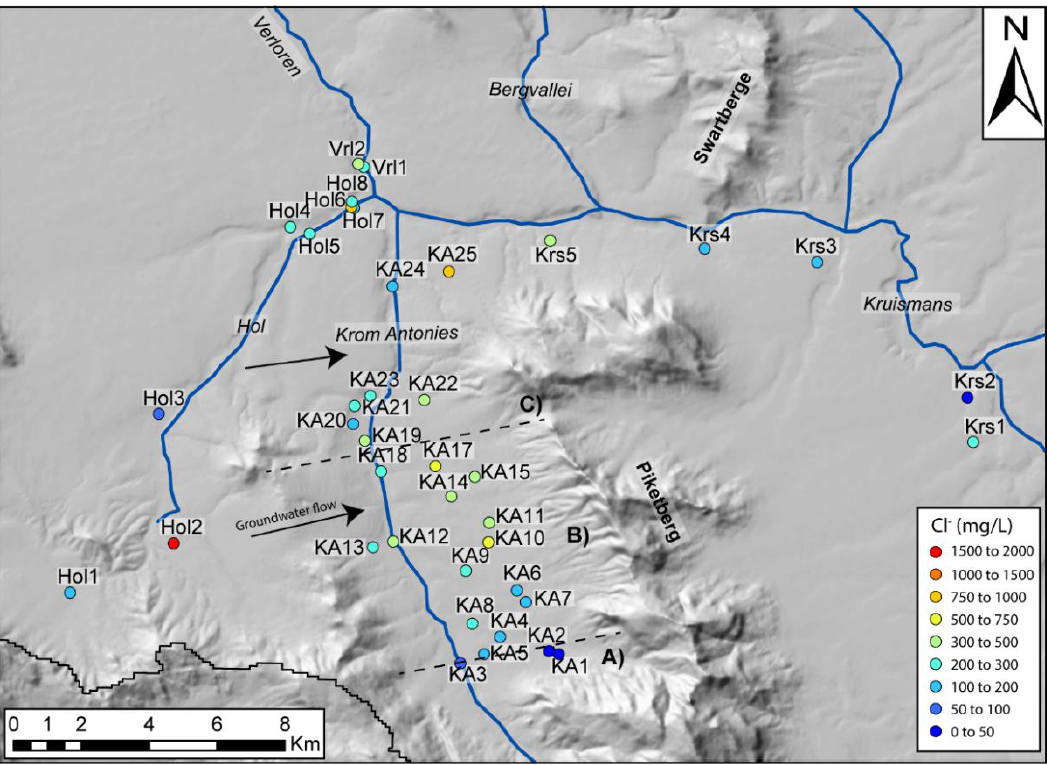
Figure 11. Delineation of groundwater zones along the Krom Antonies based on groundwater chloride concentrations. A, B and C as per Figure 10.